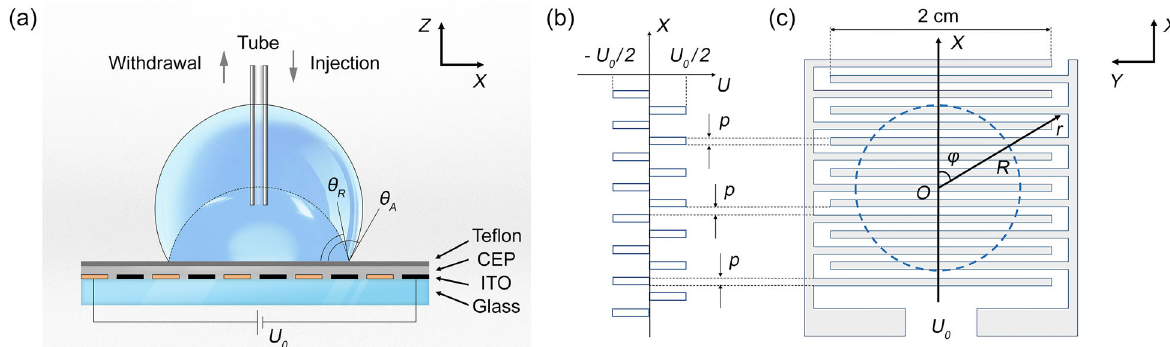
Fig. 1 Experimental set-up. a Side view. The liquid is replenished or extracted via a steel tubing. The indium tin oxide (ITO) interdigitated electrodes (IDE) are isolated from the liquid by a dielectric layer of cyanoethyl pullulan (CEP) and a hydrophobic layer of Te fl on and connected to a DC supply of voltage U 0 . Side view images were captured and analyzed using a goniometer. The two droplet pro fi les illustrate the droplet shape when the contact line is unpinned as the contact angle escapes [ θ R , θ A ] range, with θ R and θ A the receding and advancing contact angles, respectively. b Voltage across the solid – liquid interface in x direction. Due to the large aspect ratio of the IDEs, the electric potential is well approximated by a square-wave function 61,62 with p being the fi nger width and spacing of the electrodes. c Top view. The gray drawing is a representation of the interdigitated electrodes. The contact line radius of the droplet is denoted by R . In these polar coordinates, the origin O is located at the center of the circular contact area (dashed circle), with φ and r the angular and radial with ϵ l ≃ 80 ϵ 0 and ϵ 0 = 8.85 × 10 − 12 F/m the dielectric permittivity of